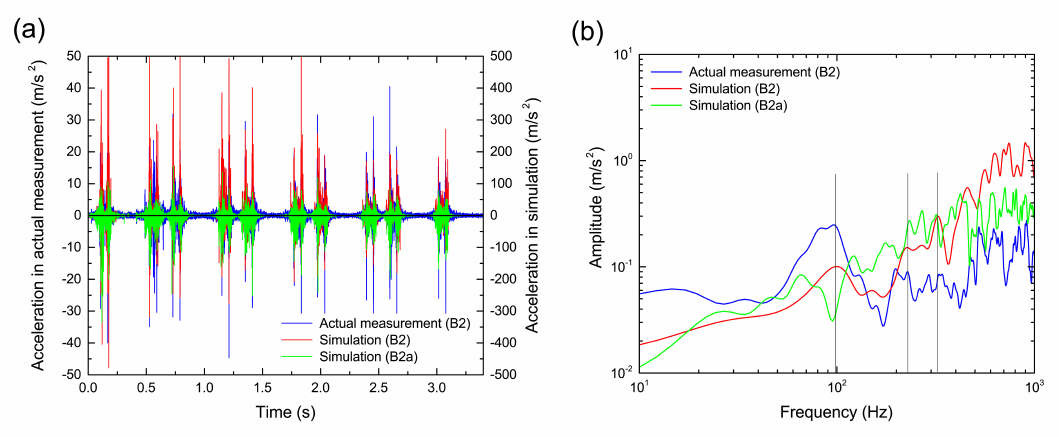
Figure 11. Comparison between numerical simulation and actual measurement in terms of vibration properties of ballast particle. ( a ) Time variation of ballast particle acceleration in vertical direction and ( b ) linear spectra of ballast particle acceleration. The linear spectra are smoothed by applying a Parzen window with a bandwidth of 20 Hz. The red and blue lines denote the ballast particle at sensor position B2. The green line denotes one of the neighboring ballast particles around sensor position